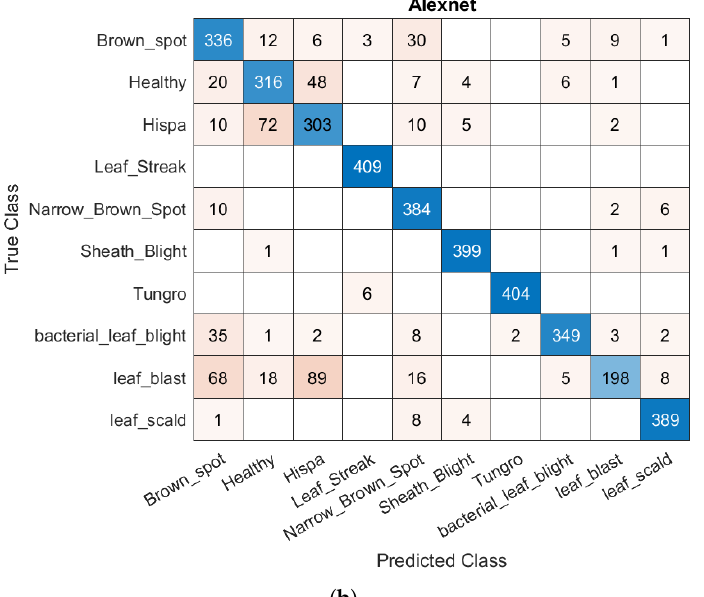
Figure 4. Confusion matrices for the finest and the poor performing pre-trained models using 60% of the training data. ( a ) InceptionResNetV2; ( b ) AlexNet. Table 7. The mean overall performance metric values using using 60% of the training data. Model InceptionResNetV2